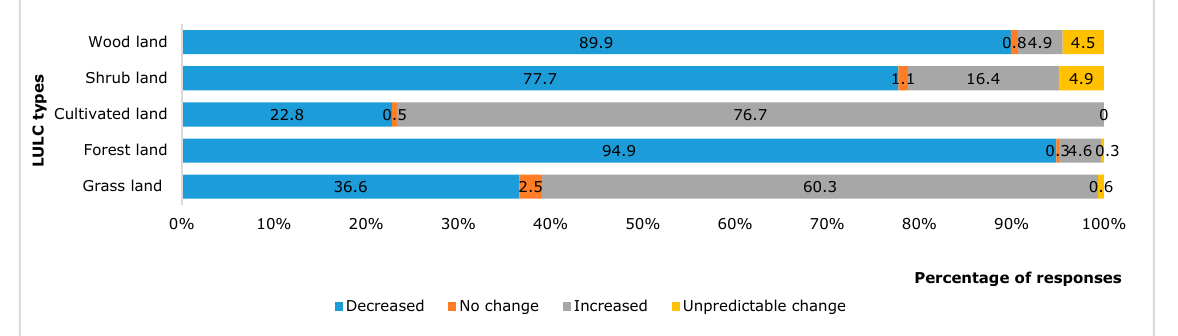
Figure 7. Respondent perceptions of observed trends at the landscape level in south-western Côte d’Ivoire.